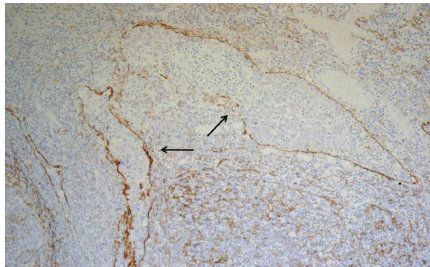
Figure 4: Lymphatic invasion is evident by D2-40 staining in the lamina propria (arrows: × 25).